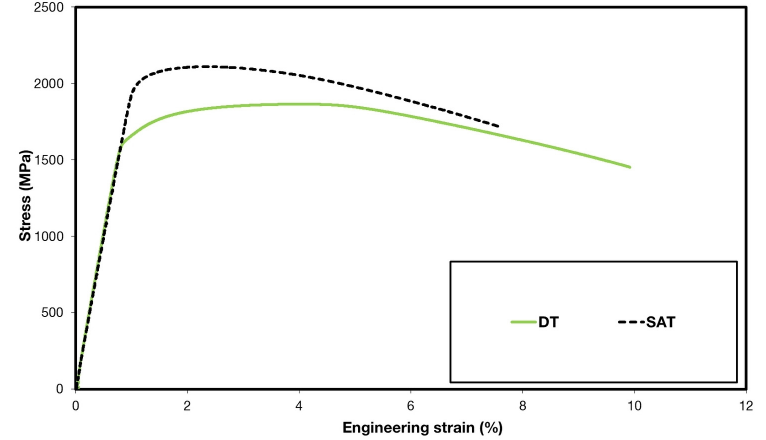
Figure 2. Representative tensile engineering stress–strain diagrams for DT and SAT treatments.